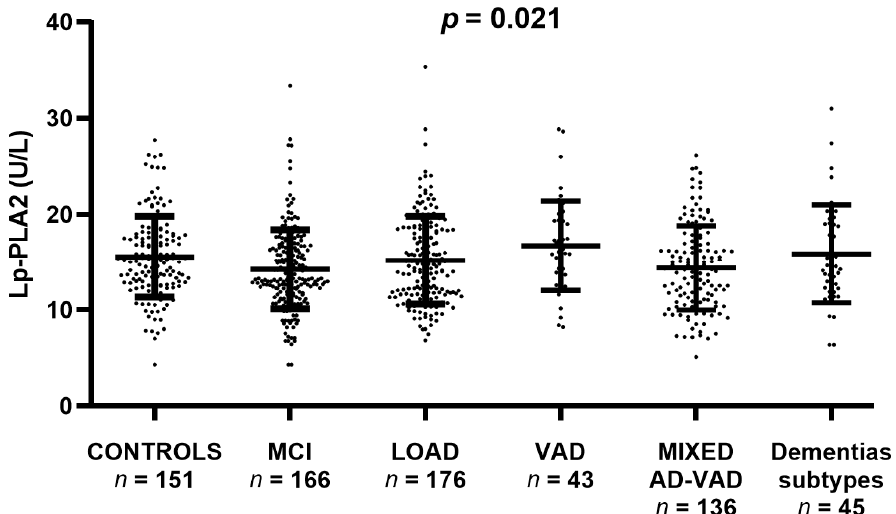
Figure 1. Serum Lp-PLA2 activity levels in Controls, Mild Cognitive Impairment (MCI), Late-Onset Alzheimer’s Disease (LOAD), Vascular Dementia (VAD), AD-VAD MIXED dementia, and other dementia subtypes. Comparison between groups was performed by ANOVA which yielded p = 0.021